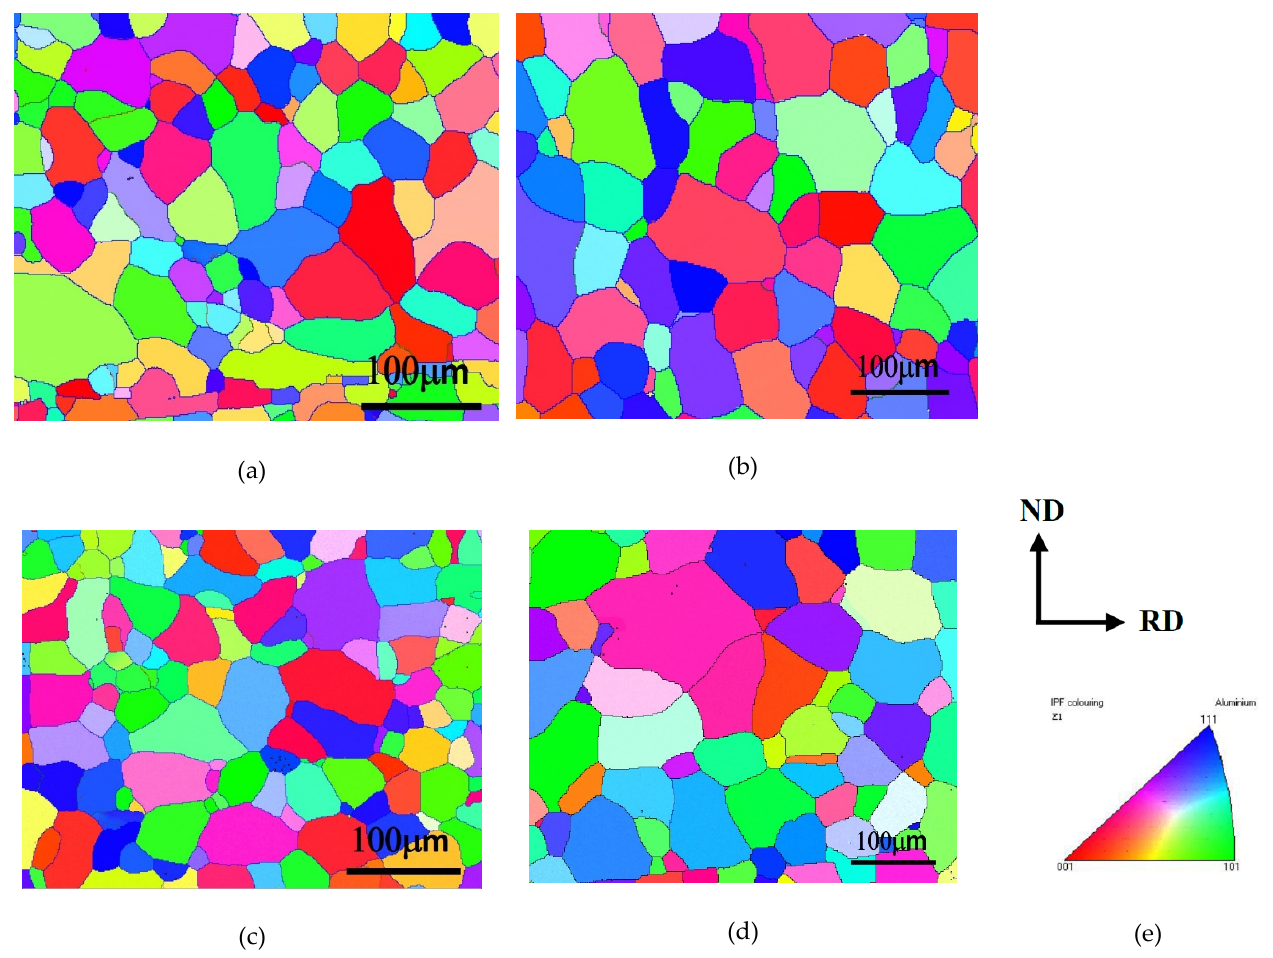
Figure 6. EBSD (Electron Backscatter Diffraction) analysis of Alloy A (0Mn) after ( a ) 1-Homo 400 ◦ C annealing for 0.5 h; ( b ) 1-Homo 400 ◦ C annealing for 1 h; ( c ) 2-Homo 400 ◦ C annealing for 0.5 h; ( d ) 2-Homo 400 ◦ C annealing for 1 H; ( e ) Inverse Pole Figure (IPF) coloring map and rolling